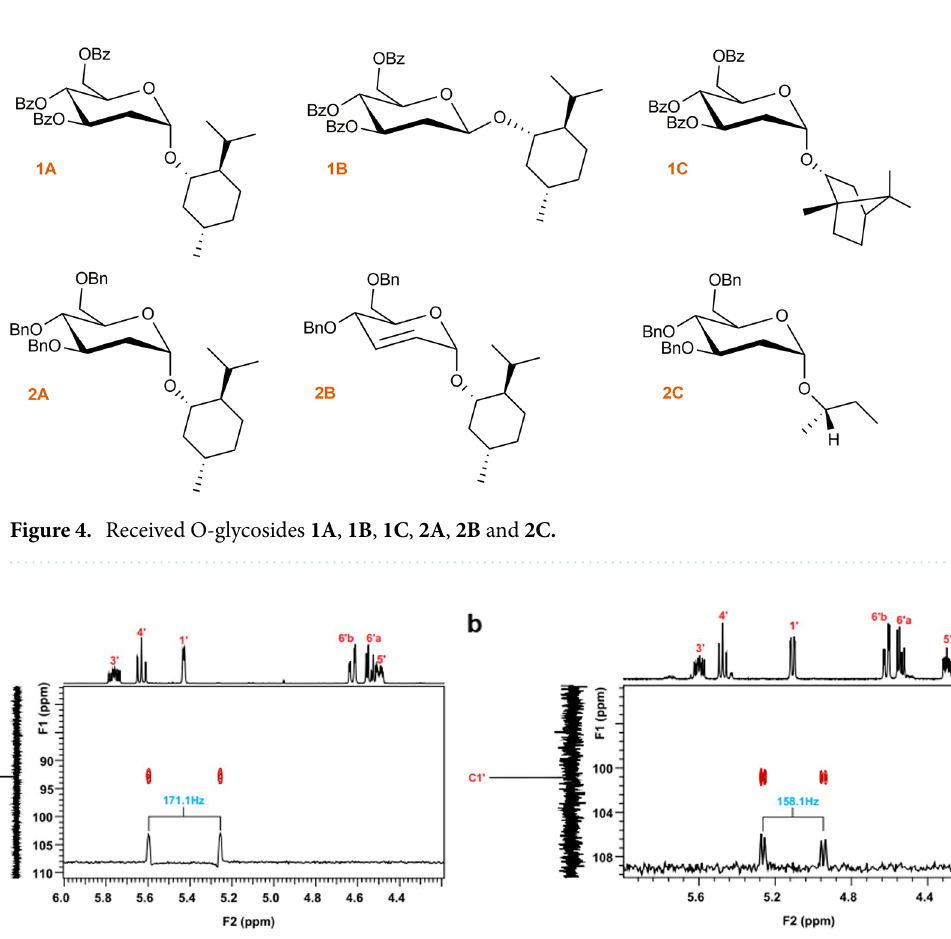
Figure 5. nd - HSQC spectra with the value of the 1 J C–H coupling constant for: ( a ) molecule 1A —alpha anomer; ( b ) 1B molecule—beta